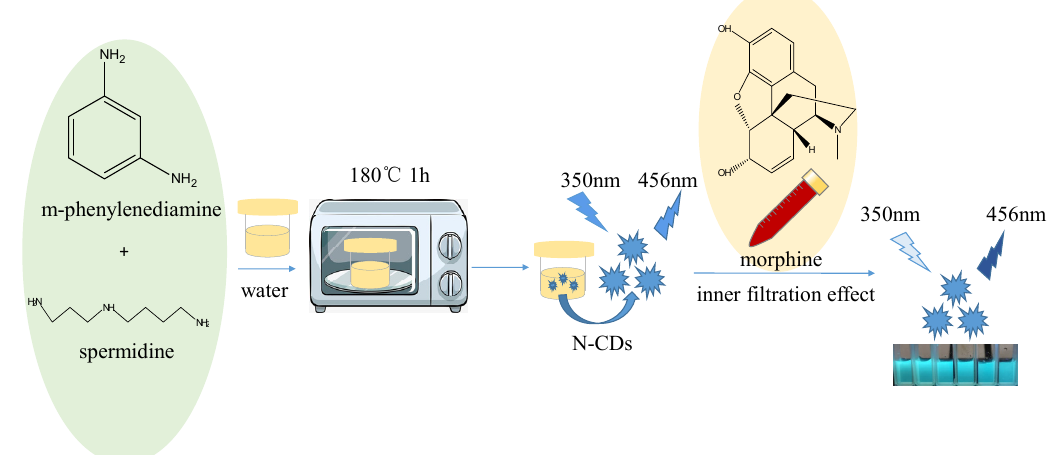
Figure 1. A schematic illustrating the synthesis and morphine detection of